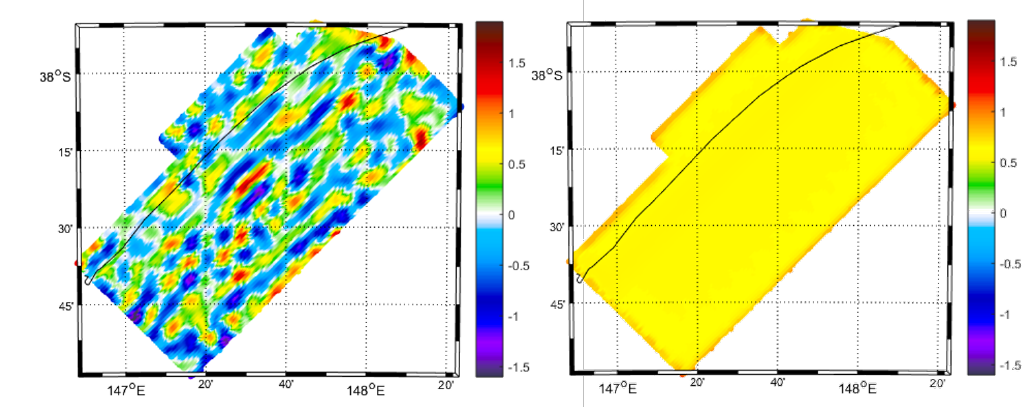
Figure 6. Difference between the estimated field and the reference one ( left ) and predicted accuracy from the simulated data ( right ). The black line represents the shoreline, where the land is located in the northwest and the sea in the south. Unit